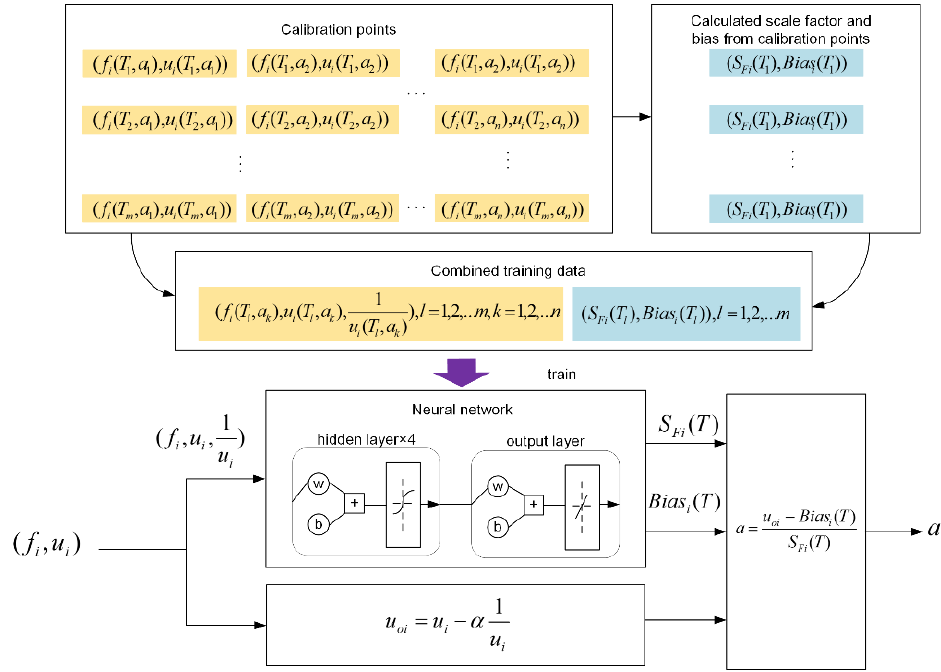
Figure 5. Data flow of the compensation process.